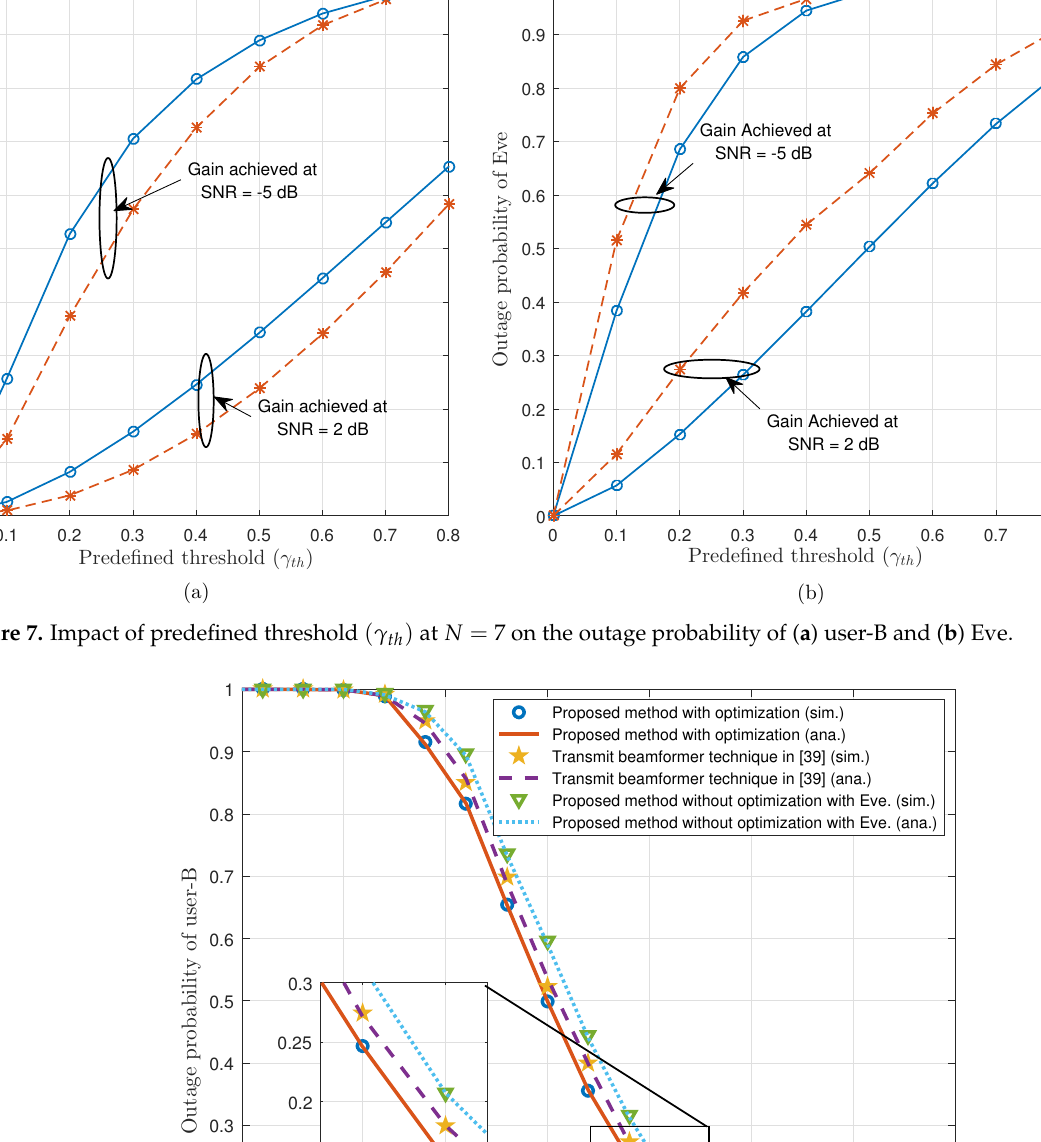
Figure 8. Outage probability comparison between transmit beamformer technique and our pro- posed